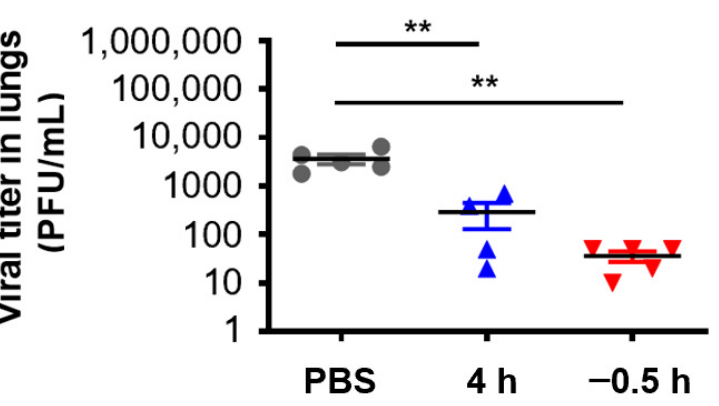
Figure 6. Virus titer in lungs of mice treated with 3HP- β -LG 0.5 h before or 4 h after viral challenge. ** denotes p < 0.01. Data are presented as mean ± SD.